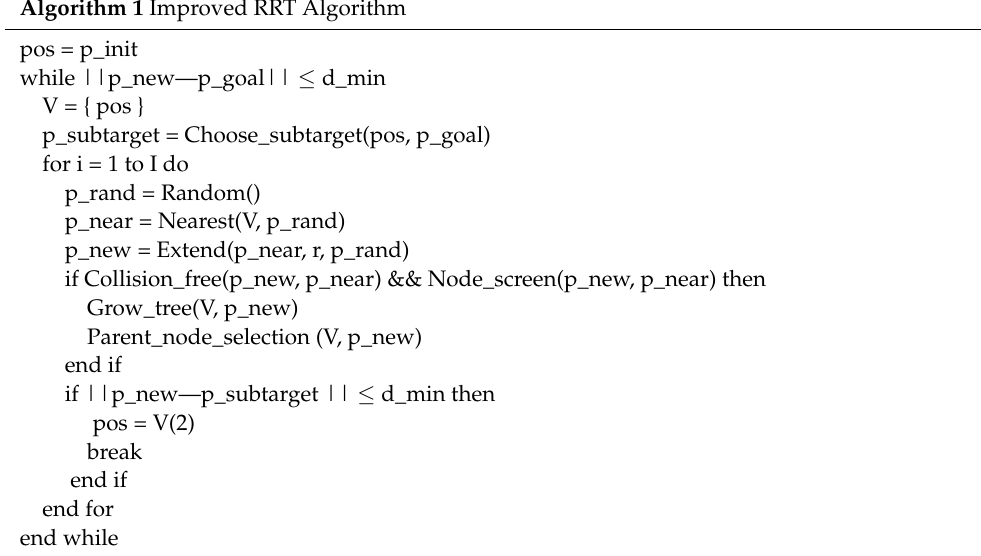
Algorithm 1 Improved RRT